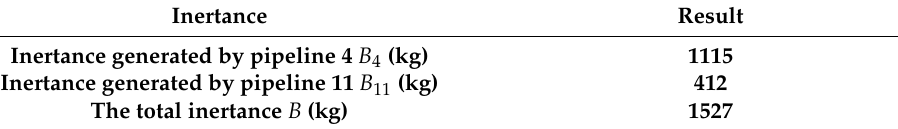
Table 2. Table of result.